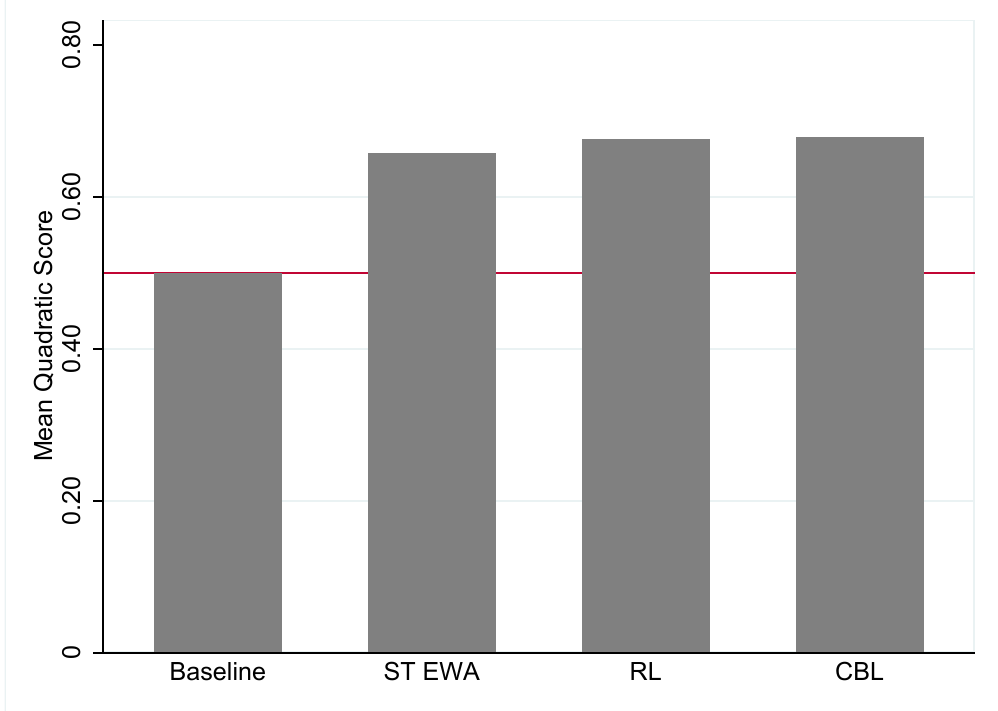
Figure 2. In-sample Fit of Learning Models. Note: The red line represents the quadratic score of the baseline model which is the predicted score of a learning model picking strategies at random. ST EWA refers to self-tuning EWA, RL refers to reinforcement learning, and CBL refers to case-based